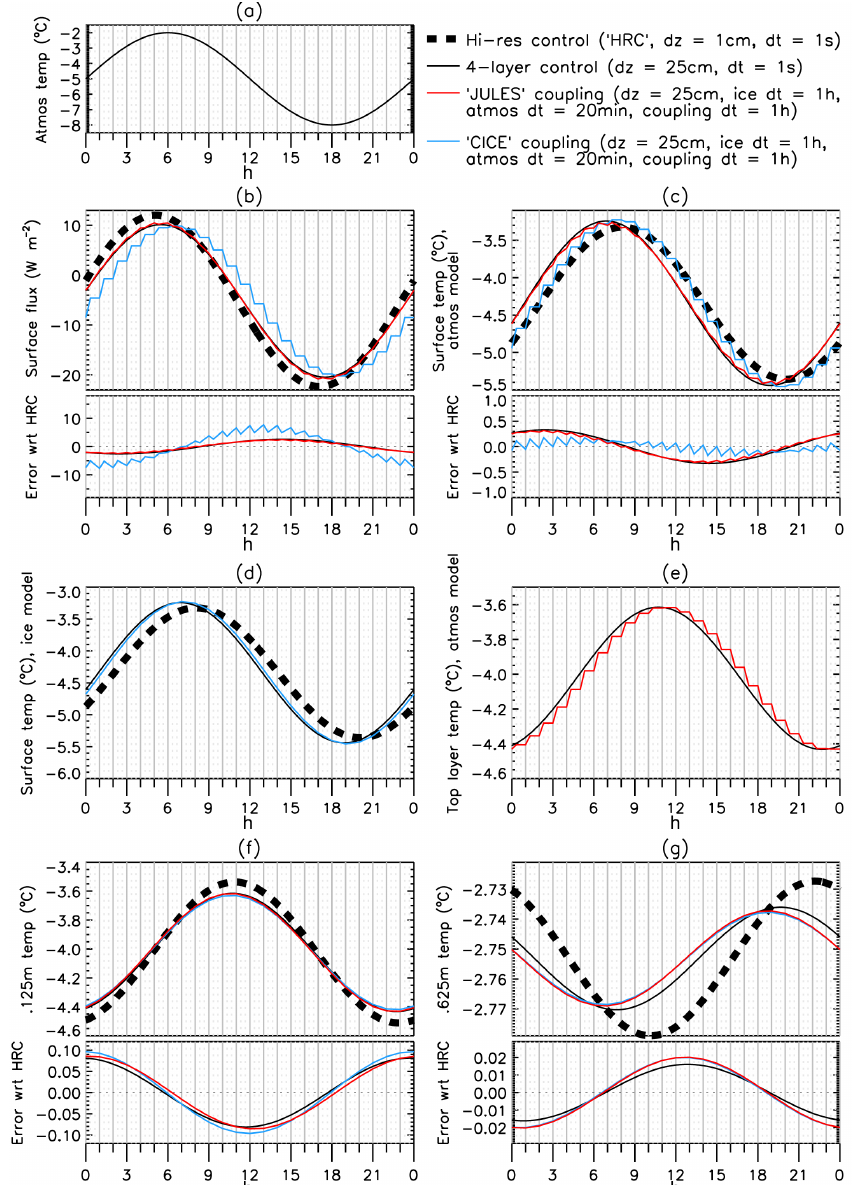
Figure 4. Comparing the two coupling methods, with a 1h coupling period. Showing (a) atmospheric air temperature (the experiment forcing); (b) surface flux; (c) surface temperature, as seen by the atmosphere; (d) surface temperature as seen by the ice; (e) 0.125m ice temperature as seen by the atmosphere; (f) 0.125m temperature as seen by the ice; (g) 0.625m